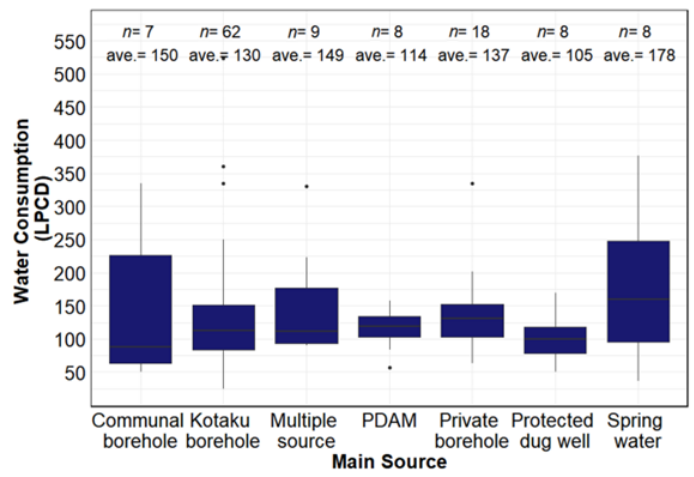
Figure 4. Household water consumption grouped by main source used ( n = 120).